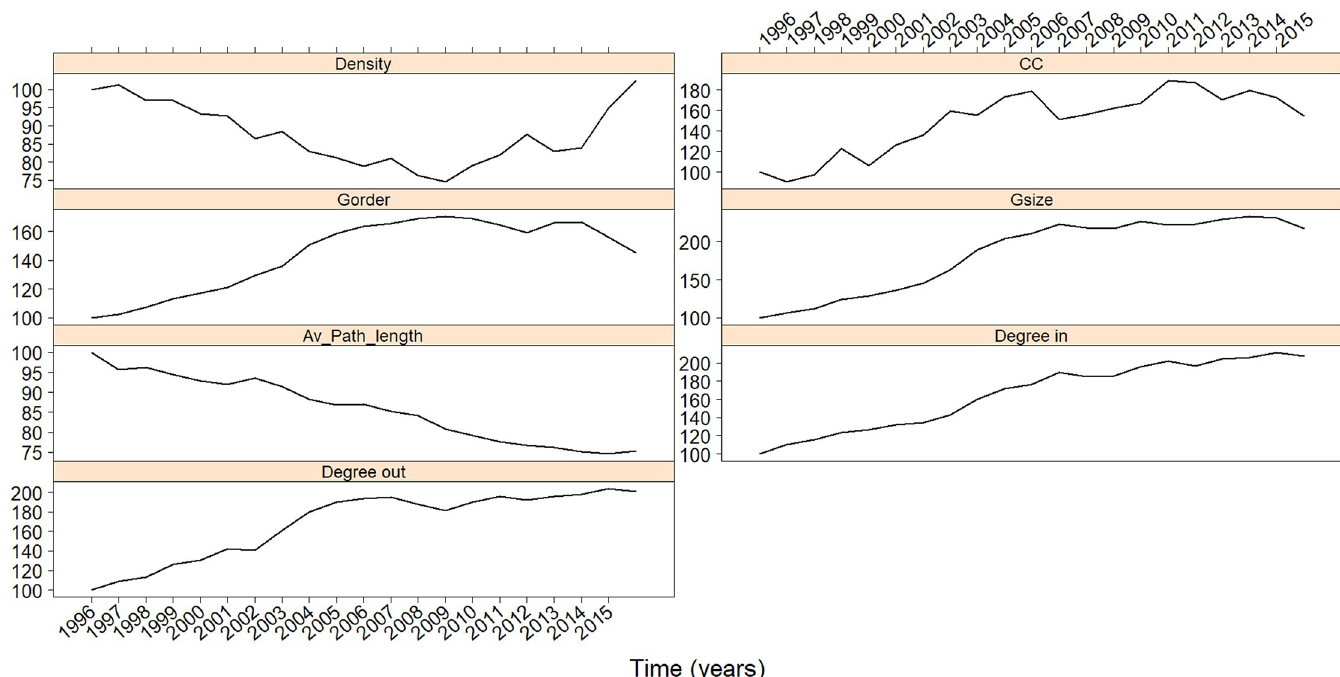
Fig 3. Evolution of the network measures (fixed base). Different descriptive network measures. Density: density of links/transfers, average (over the network nodes/ clubs). Clustering Coefficient, Gsize: number of network links/transfers, Gorder: number of network nodes/clubs, Degree-in: average number of incoming links/ transfers per club, Degree-out: average number of outgoing links/transfers per club. Years in the x-labels correspond to the first year of the season (i.e. 1996 for 1996– 1997 season).